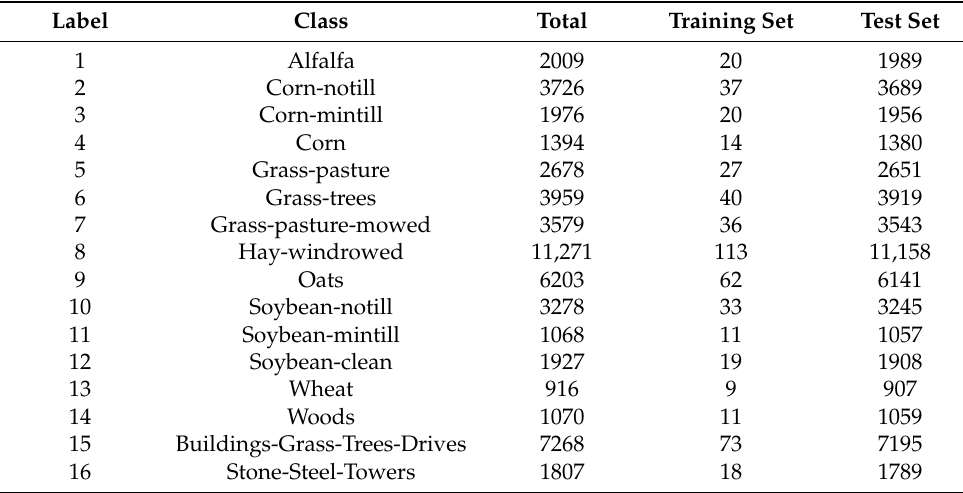
Table 4. Number of training and test samples for the SA dataset.